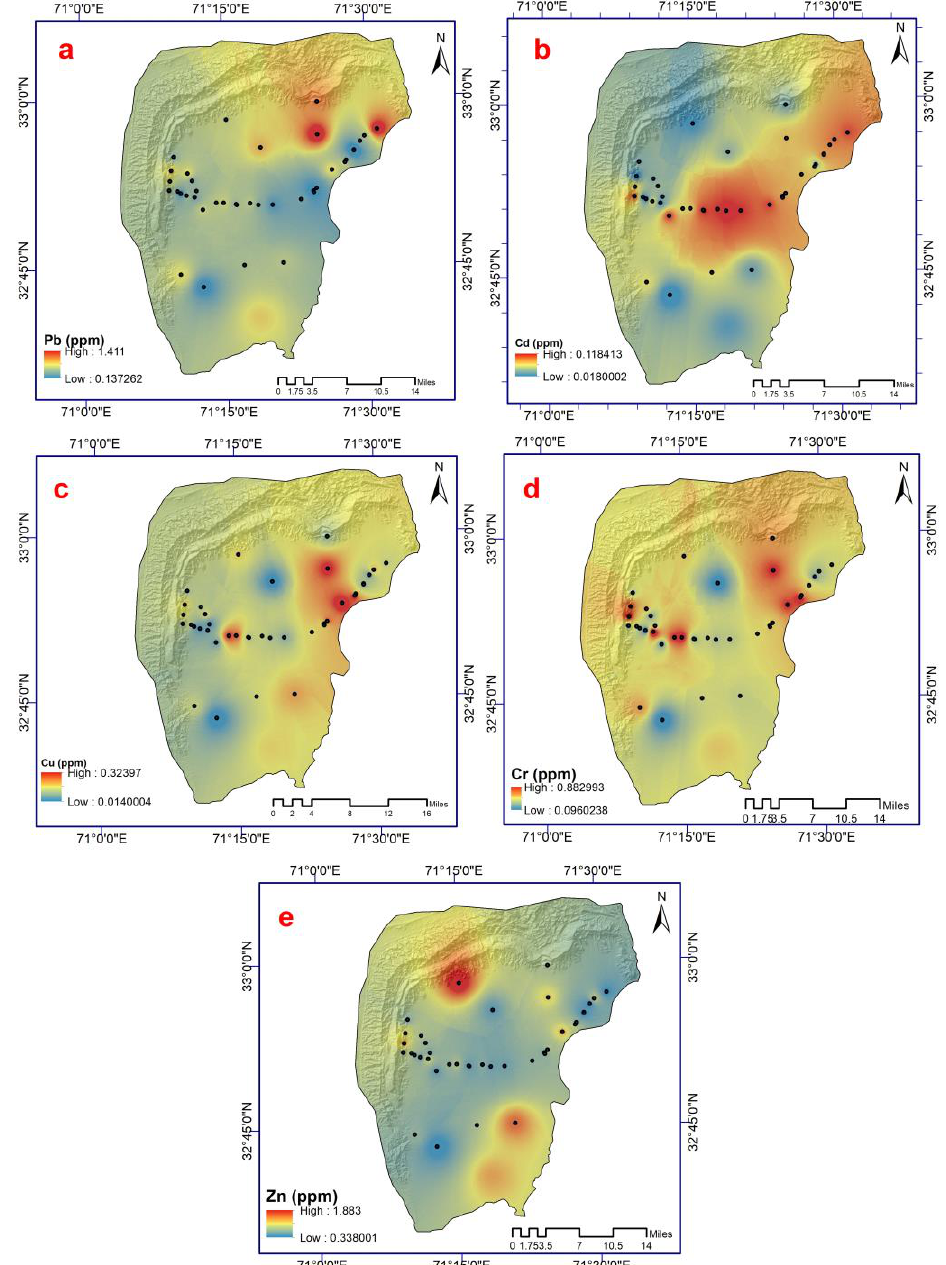
Figure 3. Distribution pattern of trace element concentrations ( a ) Pb, ( b ) Cd, ( c ) Cu, ( d ) Cr, ( e ) Zn in soil samples of the study area.